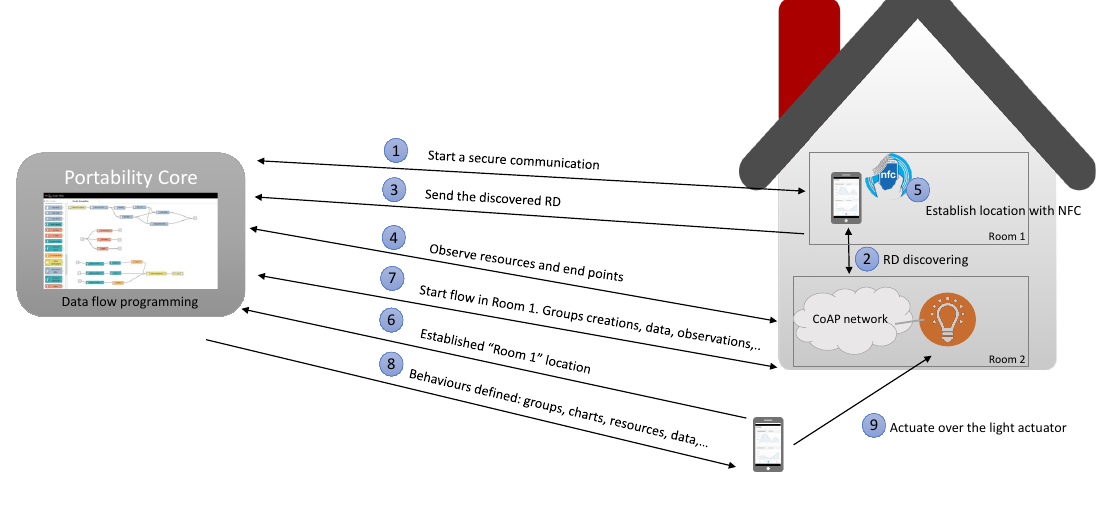
Figure 5. System interaction to actuate with a light actuator in a physical